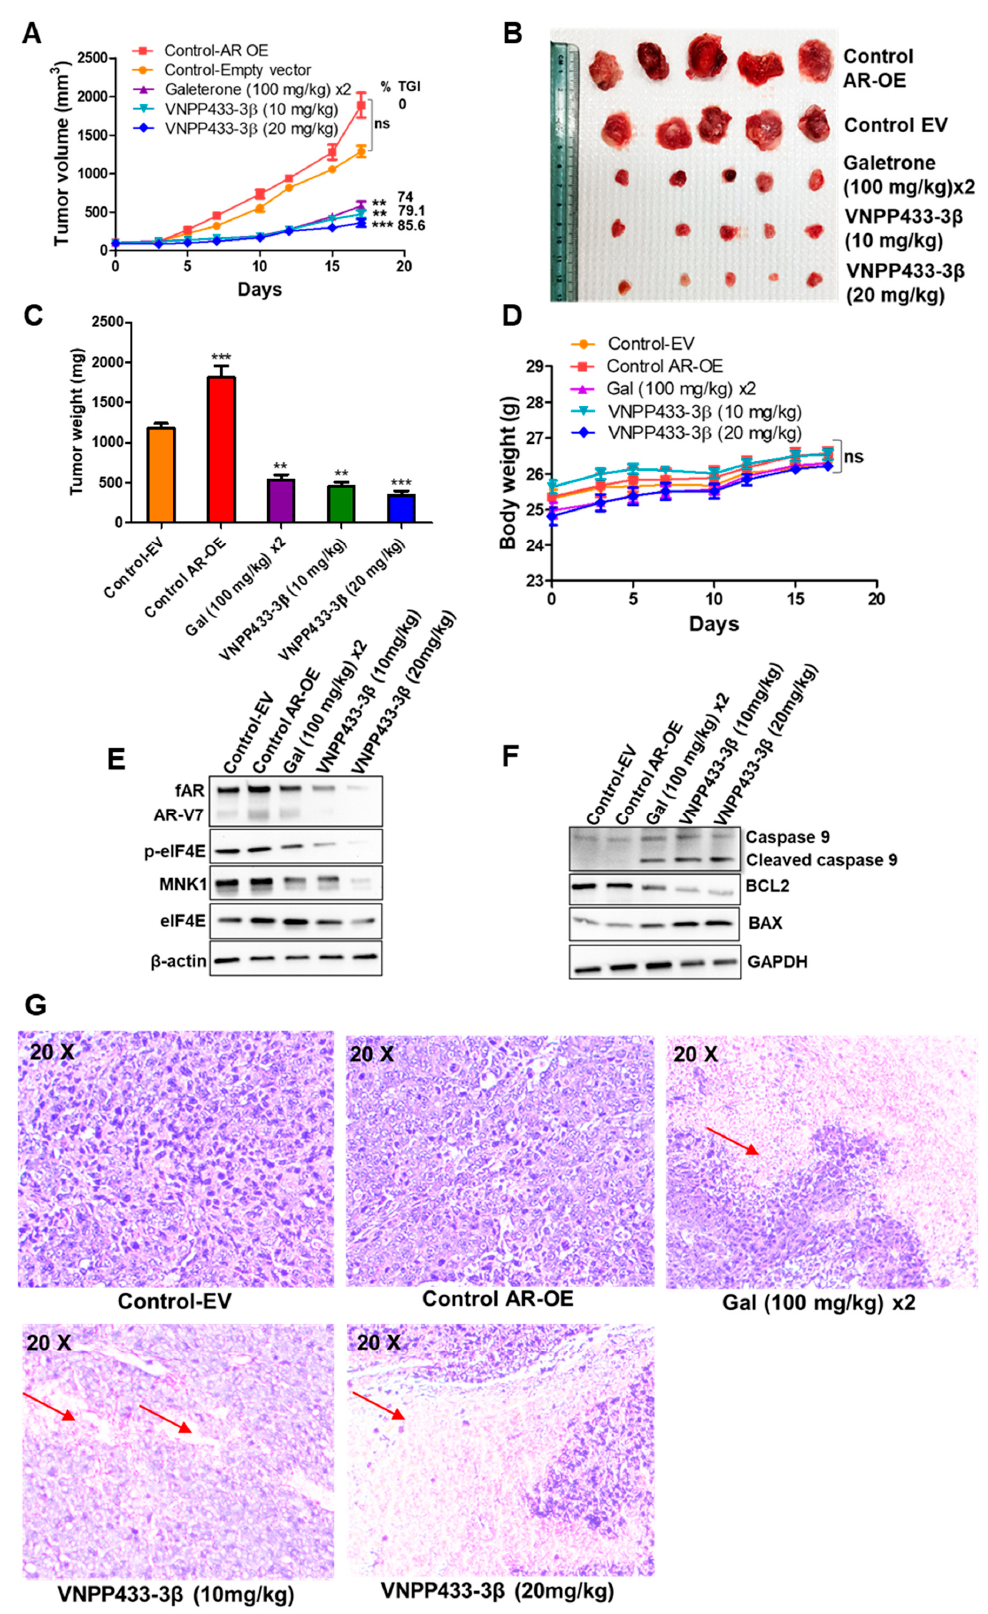
Figure 6. Effect of VNPP433-3 β in AR-over expressing 22Rv1 castration-resistant prostate cancer xenograft in vivo model. ( A ) Tumor volume in the test animals: NRG mice bearing 22Rv1 tumor xenografts that stably overexpress AR were orally administered with vehicle (40% β -cyclodextrin